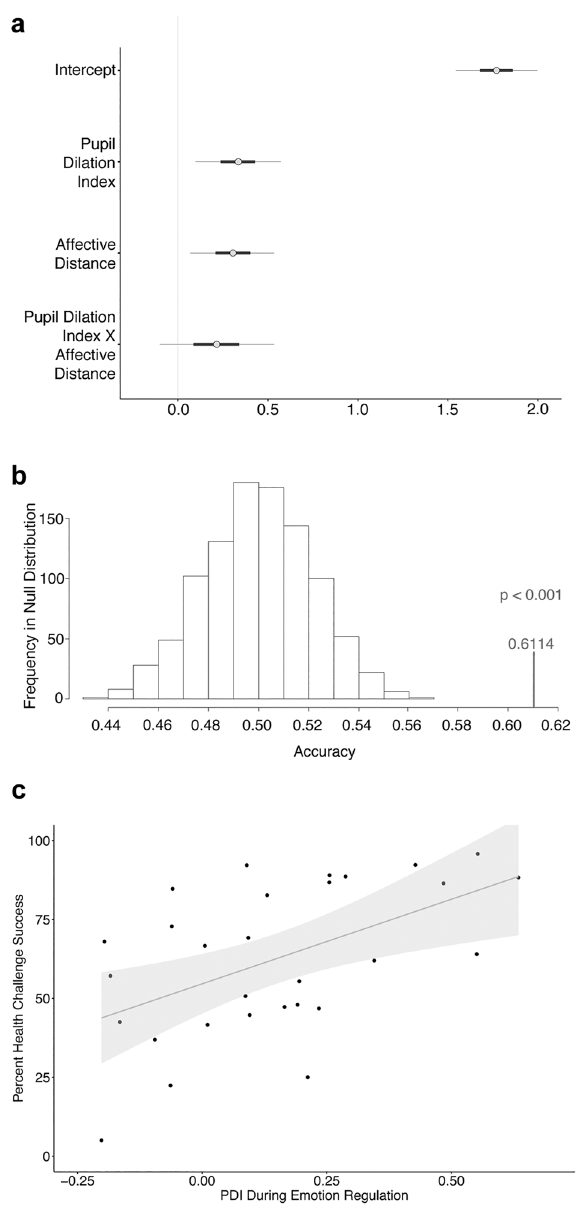
Figure 3. Predictive and convergent validity of the Pupil Dilation Index for self-regulation success. ( a ) Bayesian linear regression of self-regulation success using the model given in Eq. (3a). Pupil Dilation Index denotes the coefficient estimating the influence of regulation-related arousal components. Affective Distance denotes the coefficient estimating the influence of the mean absolute difference of the view rating from neutral (middle of the rating scale) that can be interpreted as a proxy for regulation difficulty. Regulation success increased both with greater Pupil Dilation Index and Affective Distance. The plot shows the mean beta estimates (grey dots) as well as the range of coefficients within the 90% credible interval) that is shown by the light grey horizontal bars (thick horizontal bars = 50% credible interval). ( b ) Predicting regulation success out-of-sample. The results from the model in Eq. (3a) were cross-validated with a Leave-2-Participants-Out approach. Based on data from N-2 participants, we predicted which of the two left-out individuals regulated more successfully. The model predicted with 61% accuracy significantly above chance (p < 0.001). ( c ) Convergent validity of the Pupil Dilation Index. The Pupil Dilation Index (PDI) that we measured during emotion regulation also shows convergent validity across different types of self-control tasks: a higher PDI value was associated with higher health challenge success scores within-individual in the dietary health challenge task that individuals completed in the same experimental session (r = 0.51, posterior probability rho > 0 = 0.9995), explaining 26% of the variance (R-squared = 0.26) in dietary health challenge success. The grey shaded area signifies the 95% confidence